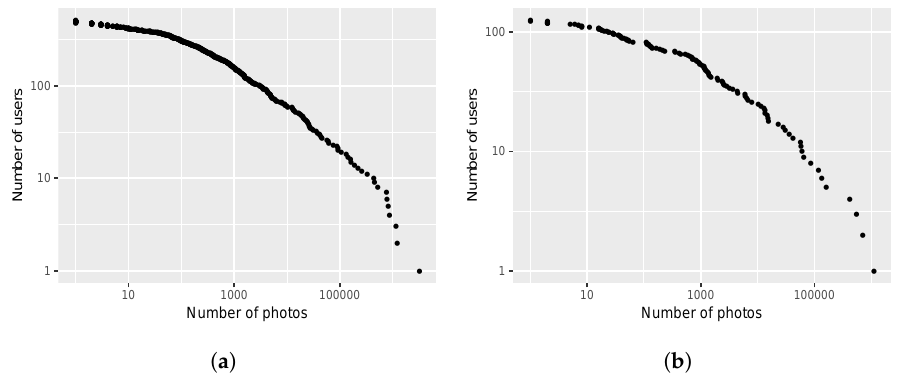
Figure 8. Distribution of user-generated images for ( a ) the entire Dutch Mapillary dataset and ( b ) for the photos within a 50-m buffer of an agricultural